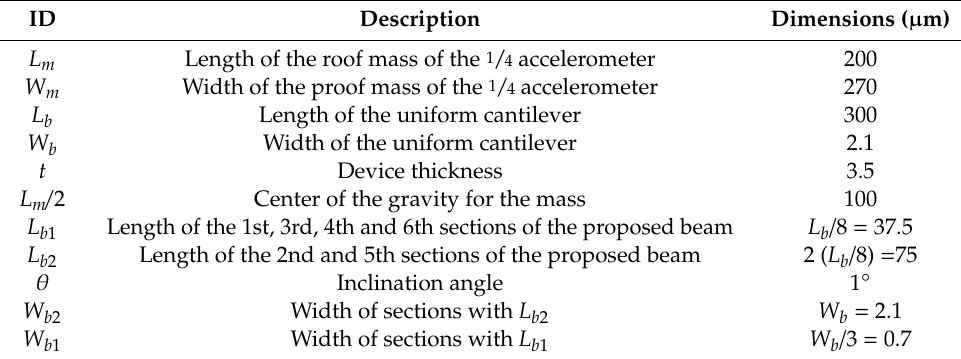
Table 4. Dimensions of mass and uniform and proposed modified